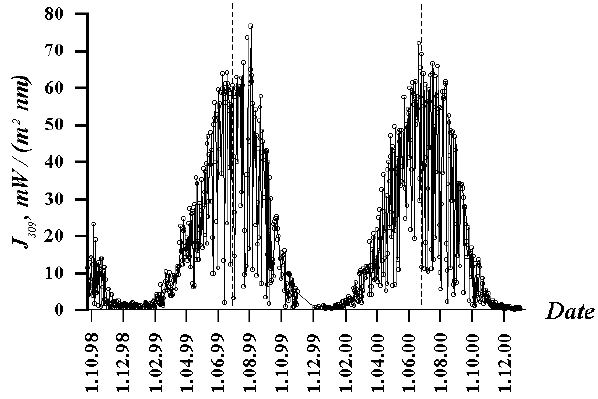
Fig. 1. The near-noon intensities of daily UVR observations on 309nm